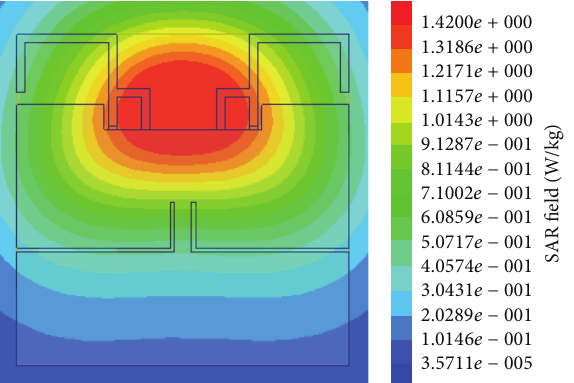
Figure 10: Simulated SAR distribution of the proposed antenna on the phantom at 2.44 GHz (input power: